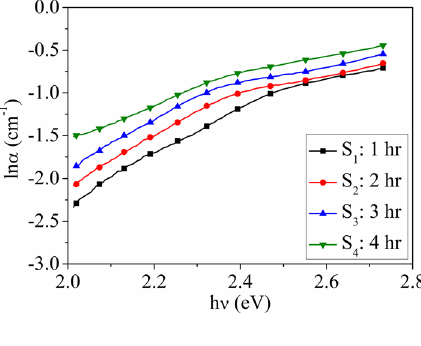
Fig. 6 The E with refluxing time for